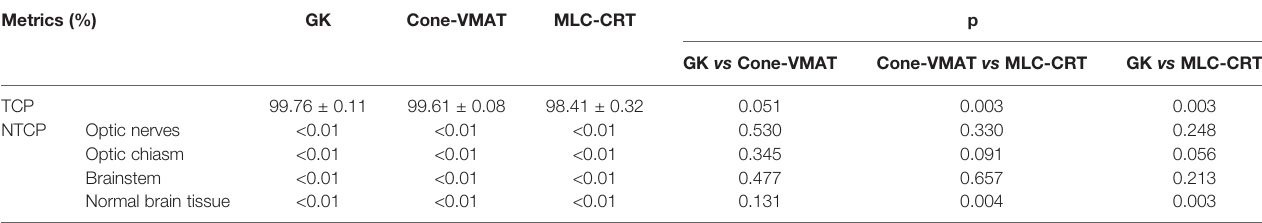
TABLE 5 | Comparison of TCP and NTCP from different plans. Metrics (%)